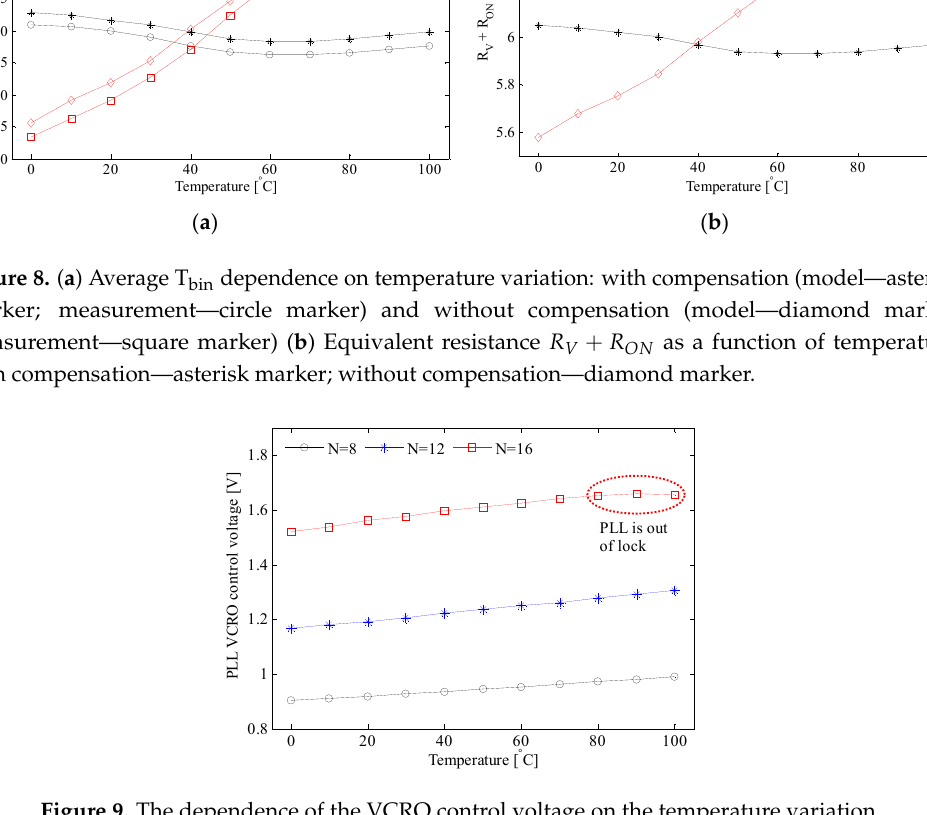
Figure 9. The dependence of the VCRO control voltage on the temperature variation.